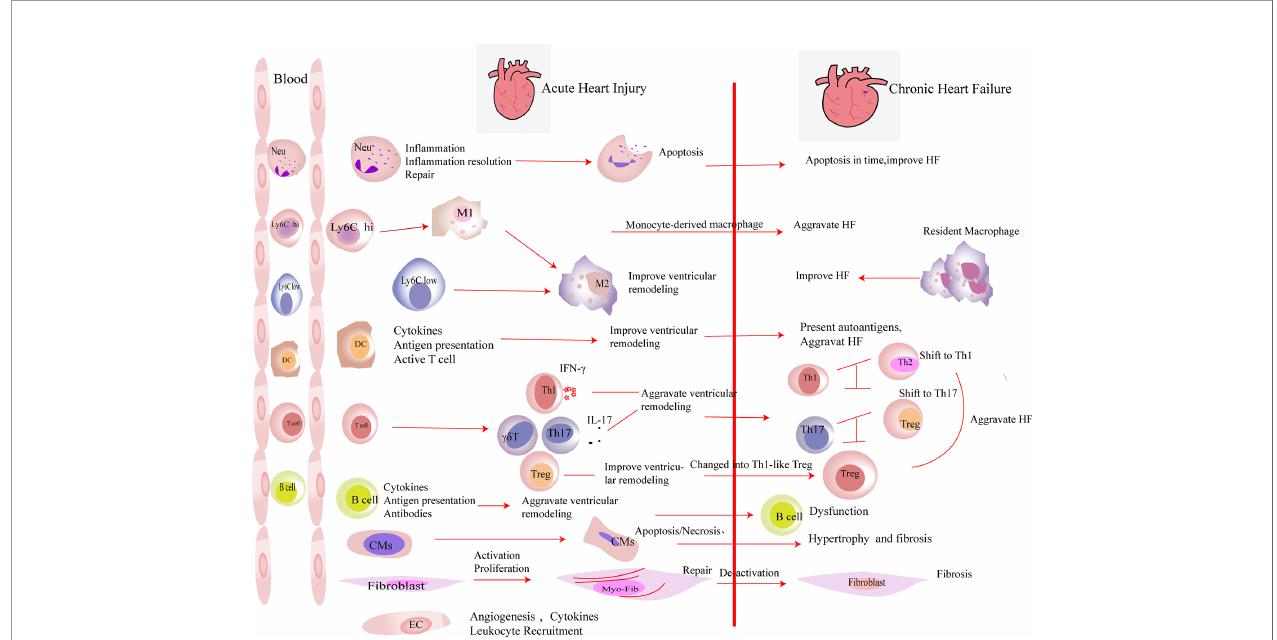
FIGURE 1 | The roles of immune cells and parenchymal cells in acute heart injury and chronic heart failure. We summarized the immune cells that in fi ltrated the heart in a large number after acute heart injury. Neutrophils (Neu) in fi ltrate the heart in the very early stage of heart injury. They participate in the in fl ammation response and then undergo apoptosis, which promote the resolution of in fl ammation. Neutrophils are indispensable in heart repair after injury. Monocytes (including Ly6C low and Ly6C hi monocytes) accumulate in the heart after acute injury and differentiate into macrophages after phagocytosis of cell debris. M2 polarization of macrophages improves the prognosis of acute heart injury. In heart failure, monocyte-derived macrophages aggravate the damage, while resident macrophages play an anti-in fl ammatory effect and improve the prognosis of heart failure. DCs participate in the in fl ammatory response in the early stage of heart injury. They secrete cytokines, present antigens, and activate T cells, which play an important role in heart repair in the early stage of damage. DCs have the ability to activate CD4 + T cells and cytotoxic CD8 + T cells, which exacerbate HF. T cells play different roles after myocardial infarction. In the early stage of myocardial infarction, they are essential for the repair, while the activated T cells aggravate the damage during heart failure. After myocardial infarction, Th1, Th17, and gd T cells aggravate ventricular remodeling by producing pro-in fl ammatory factors. In heart failure, the imbalances of Th1/Th2 and Th17/regulatory T cell (Treg) were observed. Tregs inhibit the in fl ammation response in the early stage of injury. At the same time, they produce repair-related molecules to promote repair directly. However, in heart failure, Tregs change their phenotype and function and worsen heart failure. B